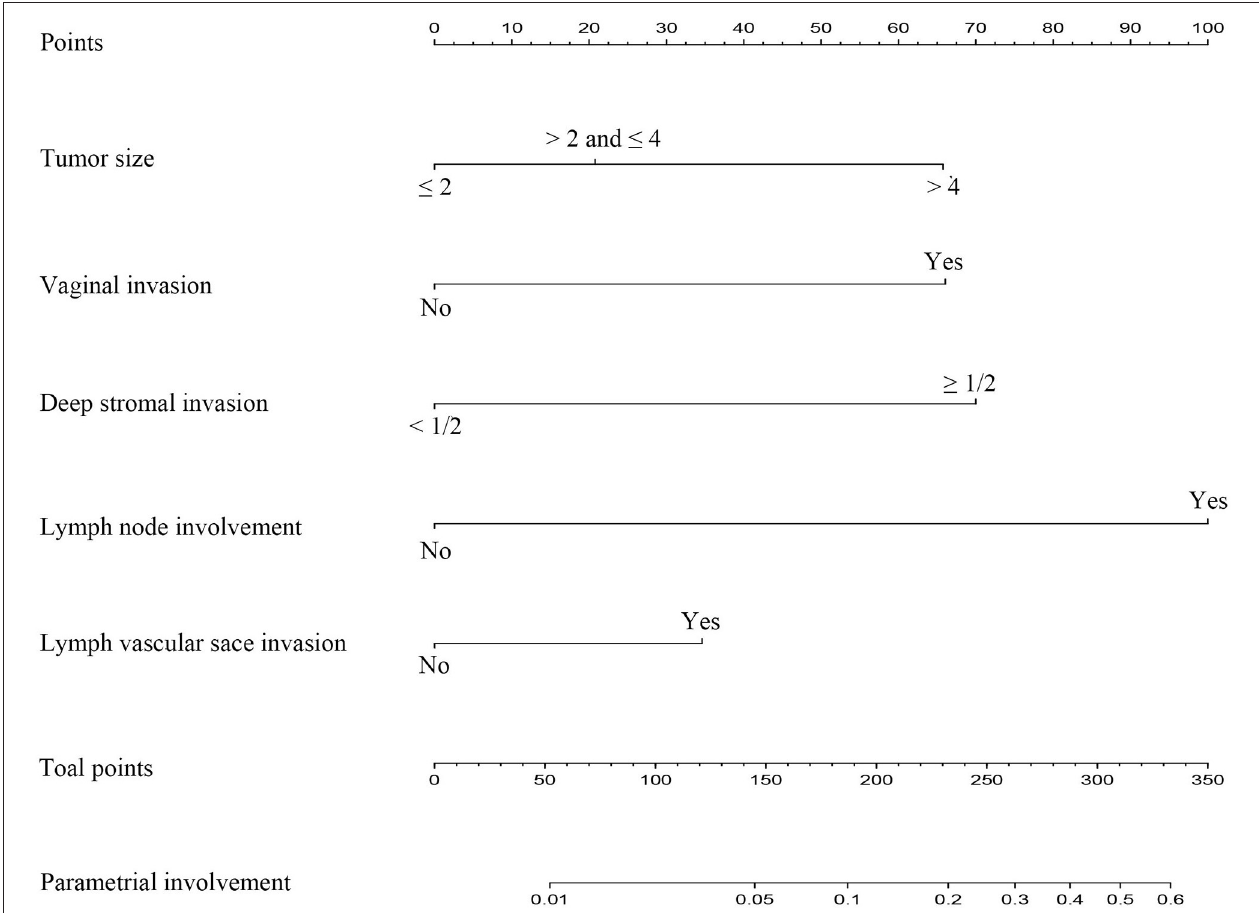
FIGURE 2 | Nomogram for predicting the parametrial invasion of the patients with the early-stage cervical cancer with five available factors including tumor size, depth of the stromal invasion, vaginal involvement, status of the pelvic lymph nodes, and the lymphovascular space